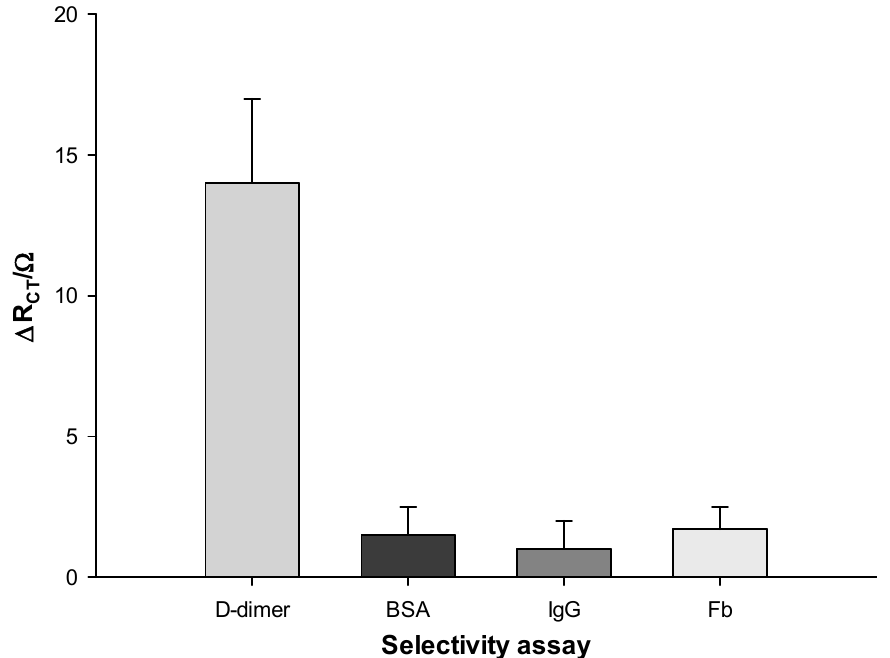
Figure 6. Histogram of selectivity assay for D-dimer antigen (10 µ g L − 1 ) vs. different interferent proteins (100 µ g L − 1 ) Zobell’s solution.